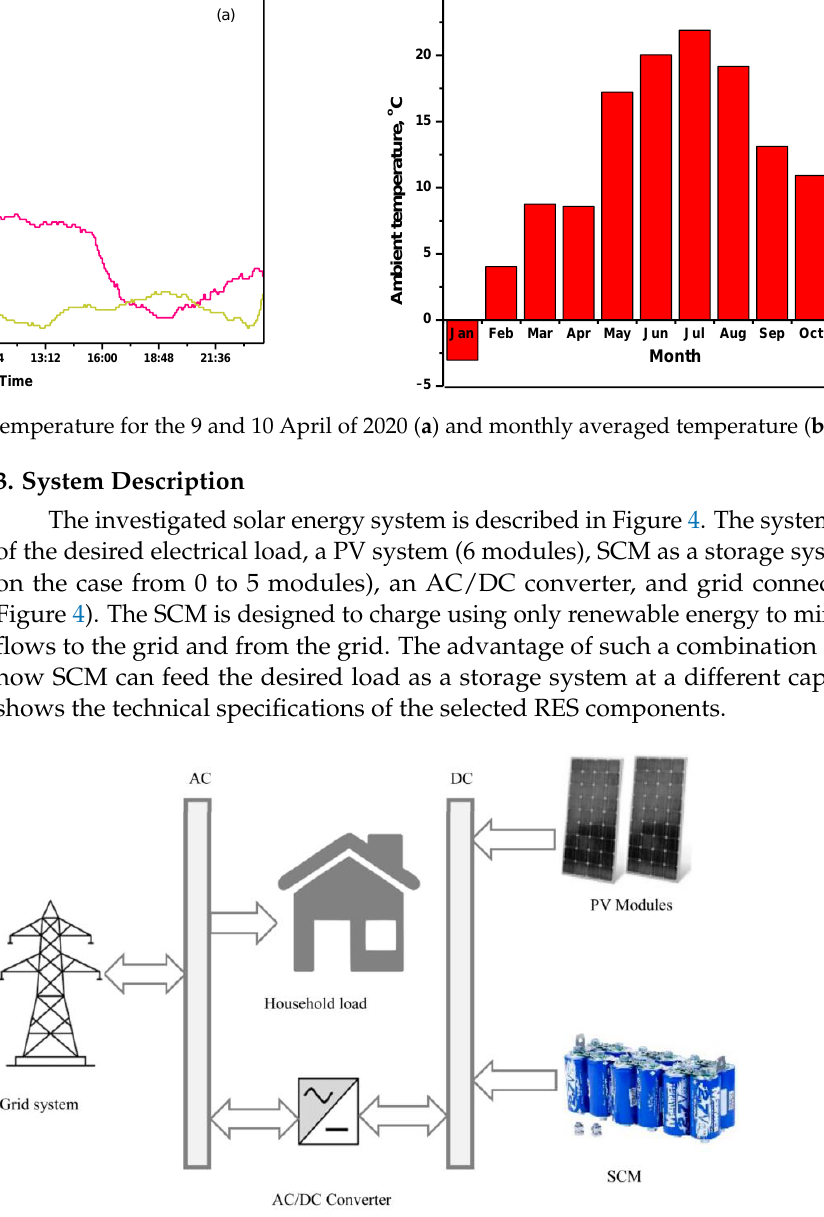
Figure 4. An analyzed on-grid PV/SCM energy system. Table 1. Specifications of the selected RES